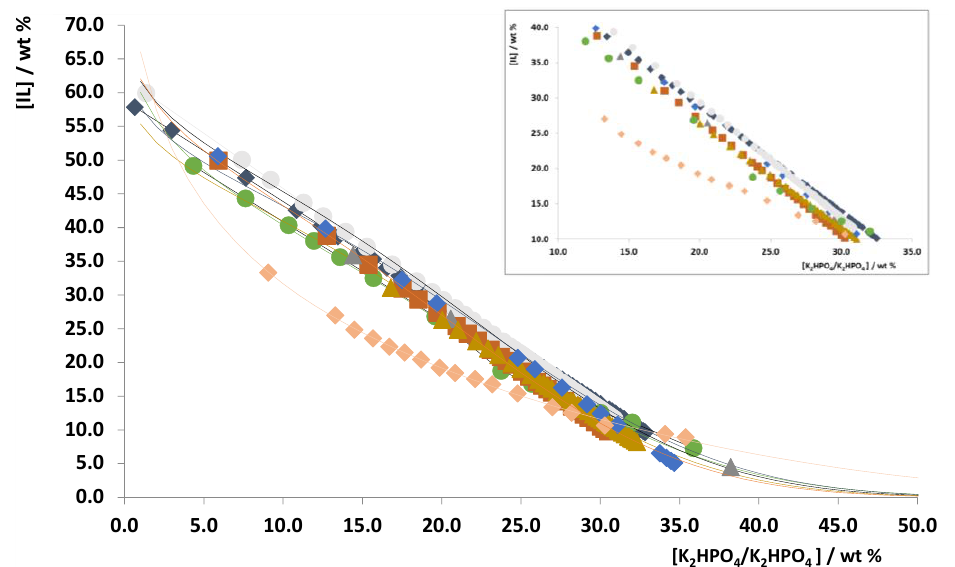
Figure 2. Phase diagrams for the systems composed of ionic liquid + K 2 HPO 4 /KH 2 PO 4 buffer at pH 7 + H 2 O at 25 ◦ C: (C 4 mim][MES] ( • ); [N 4444 ][MES] ( (cid:7) ); [P 4444 ][MES] ( (cid:78) ); [N 4444 ][Arg] ( (cid:78) ); [P 4444][ Arg] ( (cid:7) ); [C 4 mim][Ac] ( (cid:7) ); [N 4444 ][Ac] ( (cid:4) ); [P 4444 ][Ac] ( • ). The solid lines represent the fitting by